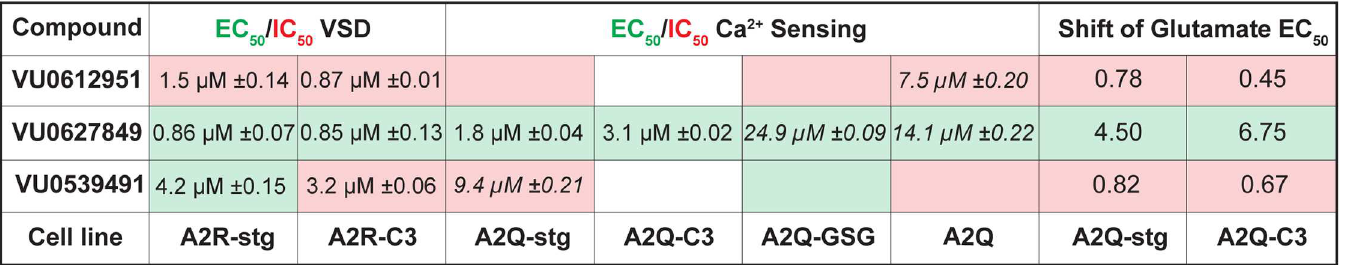
Fig 5. Table of results from VSD and calcium flux assays. EC 50 or IC 50 values determined by CRC fits from GLUslope. Boxes highlightedgreen indicate an EC 50 or a positive trend, red indicatean IC 50 or a negativetrend. Estimated EC 50 values are added in italics, but are estimated due to incompleteCRC curves or insufficientdifferences in %max GLUslopeacross the CRC. Glutamate potency fold-shift assays indicatehow much fold-change occurred in the glutamate EC 50 when cells were pretreatedwith 30 μ M compound.Values greater than 2 indicatePAM activity and less than 1 indicate NAM activity.